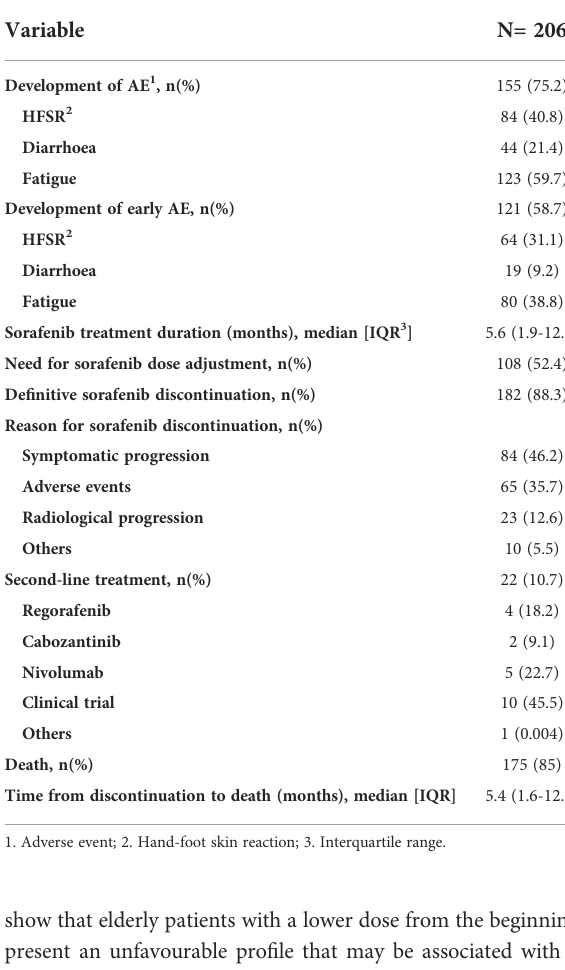
TABLE 3 Sorafenib treatment characteristics and adverse